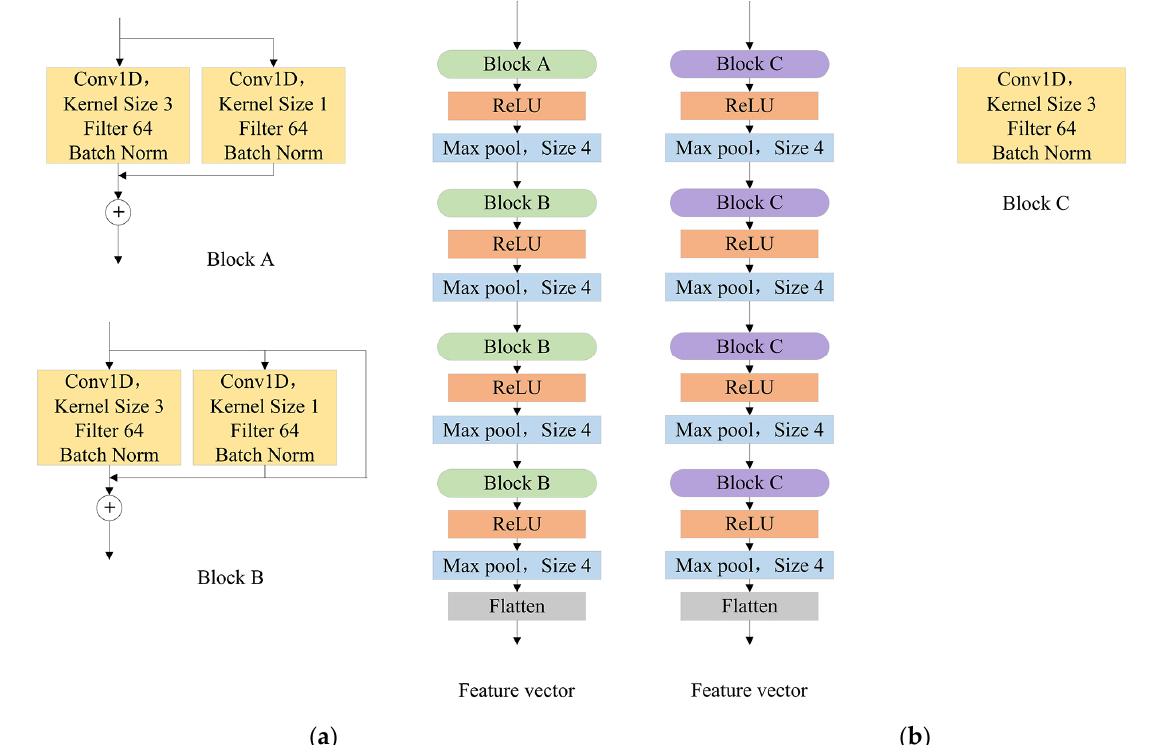
Figure 5. ( a ) Training architecture shows the structure in the training process, which includes two or three branches to improve performance; ( b ) Inference architecture is the structure in the test process, which is transformed from multi-branch by architecture re-parameterization.